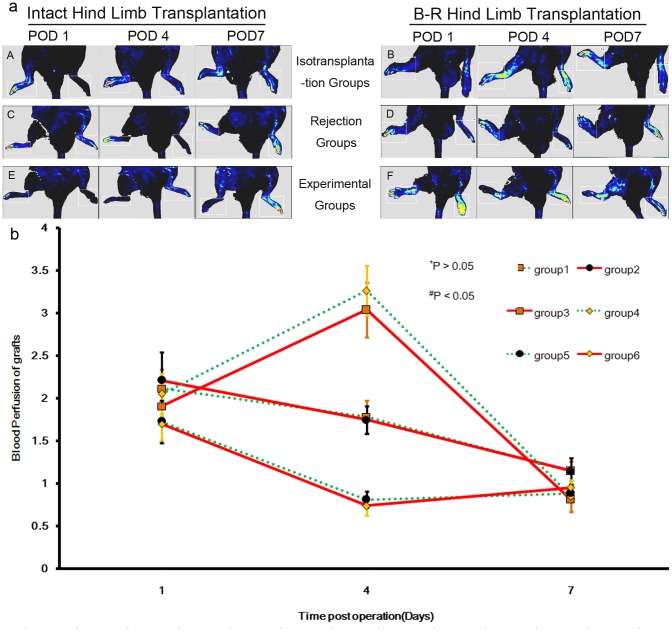
Dynamic changes of blood perfusion in grafts of the recipients.(a) All transplantations were successful, as confirmed by the considerable blood supply of the transplanted grafts according indicated by LDF. (b) The perfusion ratio between intact hind limbs and B–R hind limbs in each group was analyzed. Blood perfusion in isograft controls showed a smooth course of recovery during the observation period. In rejection groups, it peaked at POD 4 and then decreased sharply to a level below that of the contralateral limb. Blood perfusion became undetectable when they were rejected at POD 11. The blood perfusion of transplanted grafts in experimental groups remained low at all times, and ebbed at POD 4. Then it increased to a level below that of the contralateral limb at POD 7. Mean blood perfusion of grafts did not show any significant differences between any two groups given the same treatment at any point in time point (*
P>0.05). In contrast, all pairs of rejection and experimental groups showed statistical differences at POD 4 (#
P<0.05).